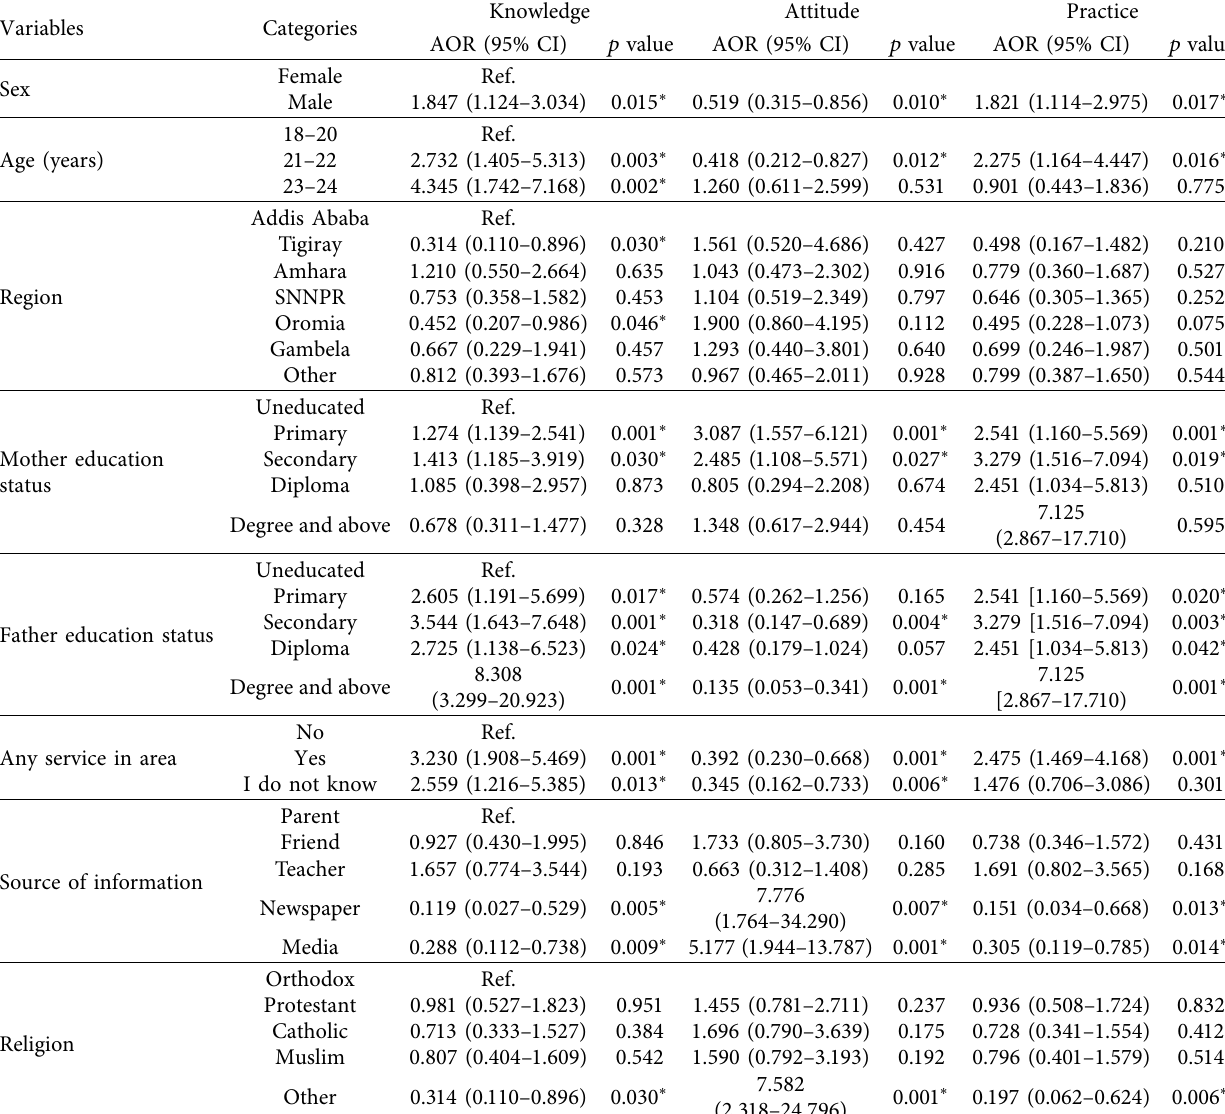
Table 6: Multiple logistic regression results of knowledge, attitude, and practice of students toward